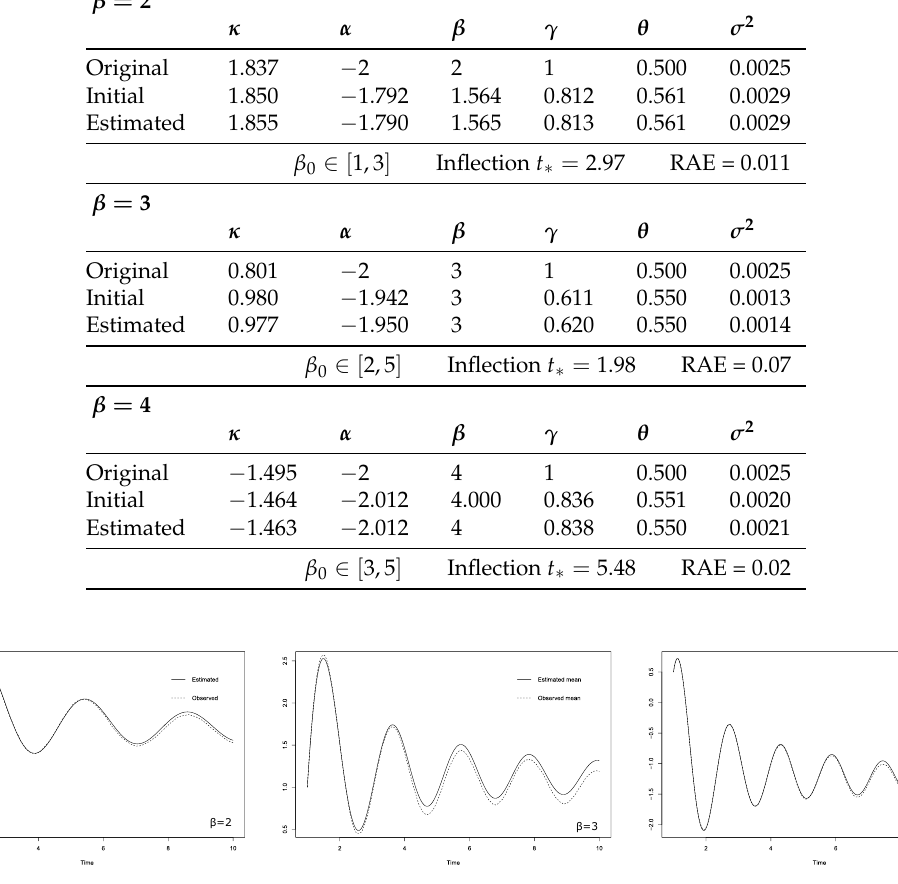
Table 2. Results for simulated Gaussian diffusion with different parameters.